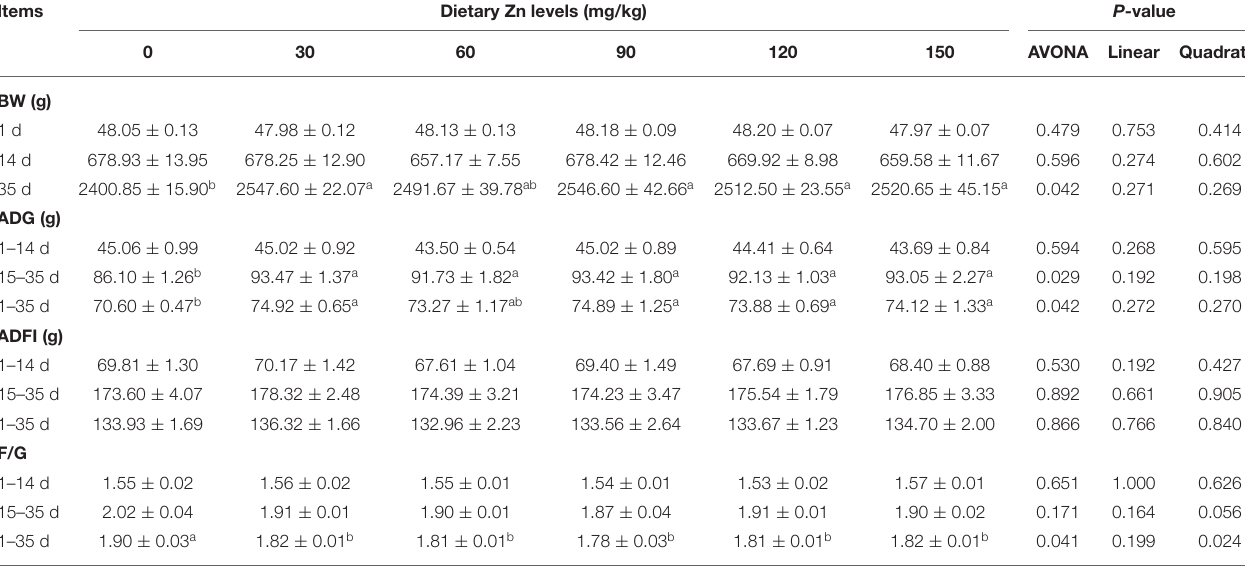
TABLE 4 | Effect of dietary Zn-Met on growth performance of